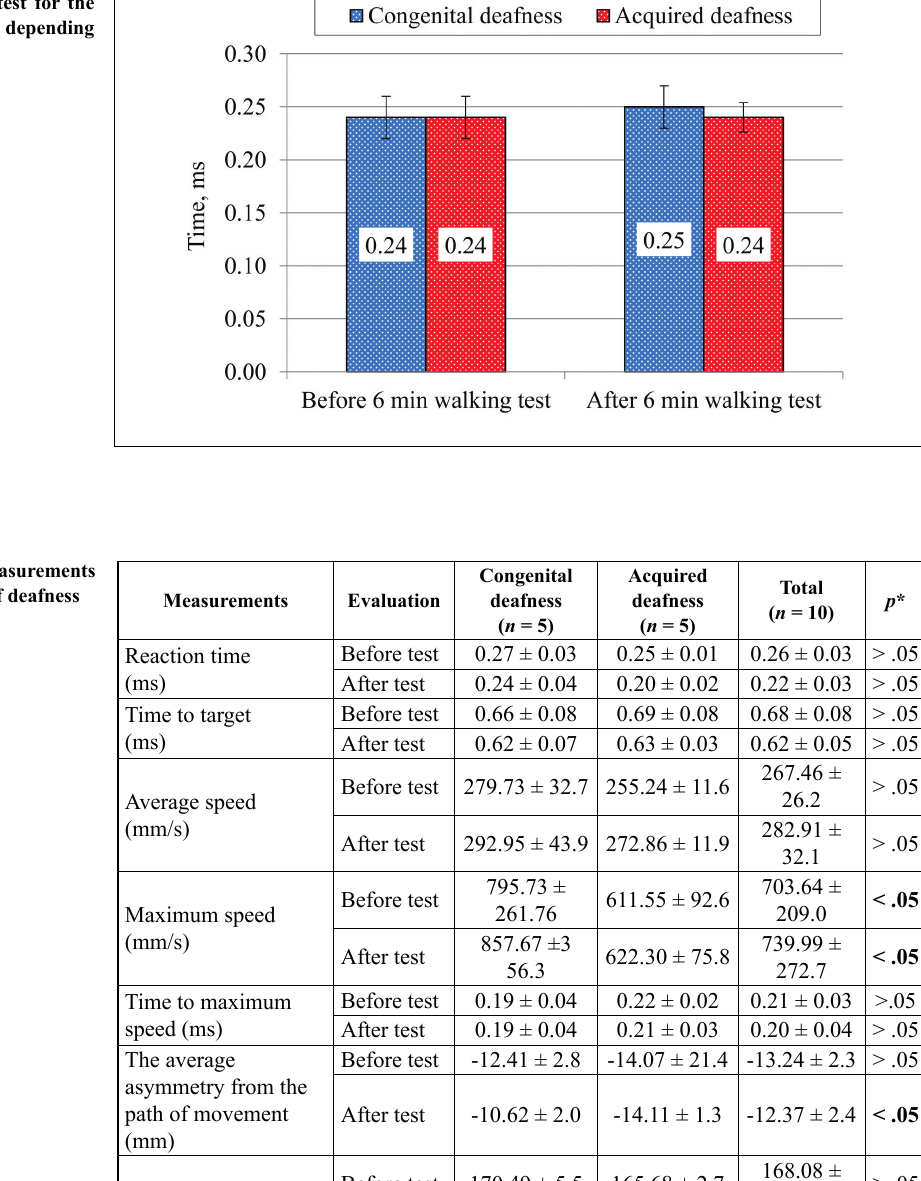
Figure 1. Simple reaction time before and after 6 min walking test for the participants in the group depending on the nature of deafness